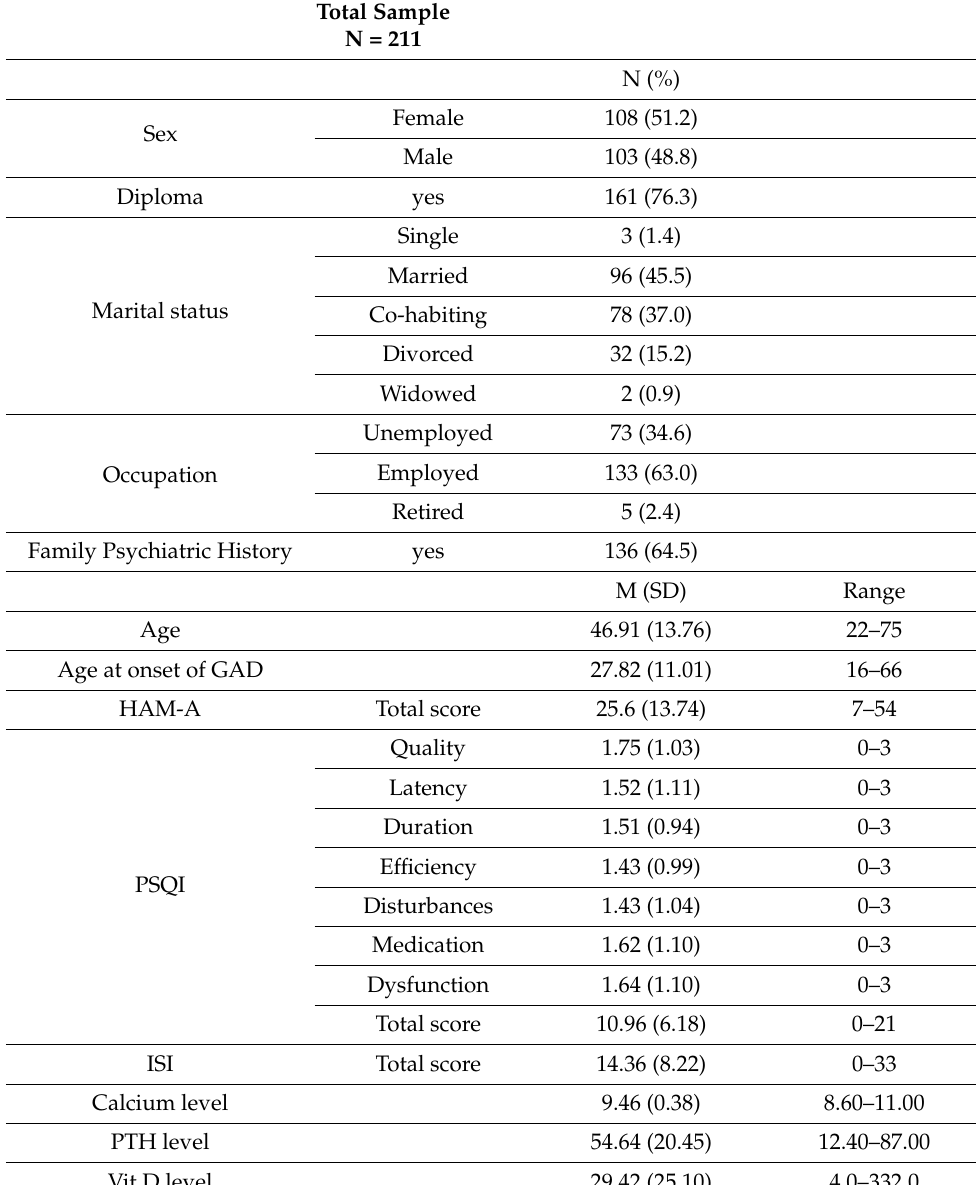
Table 2. Socio-demographic and clinical